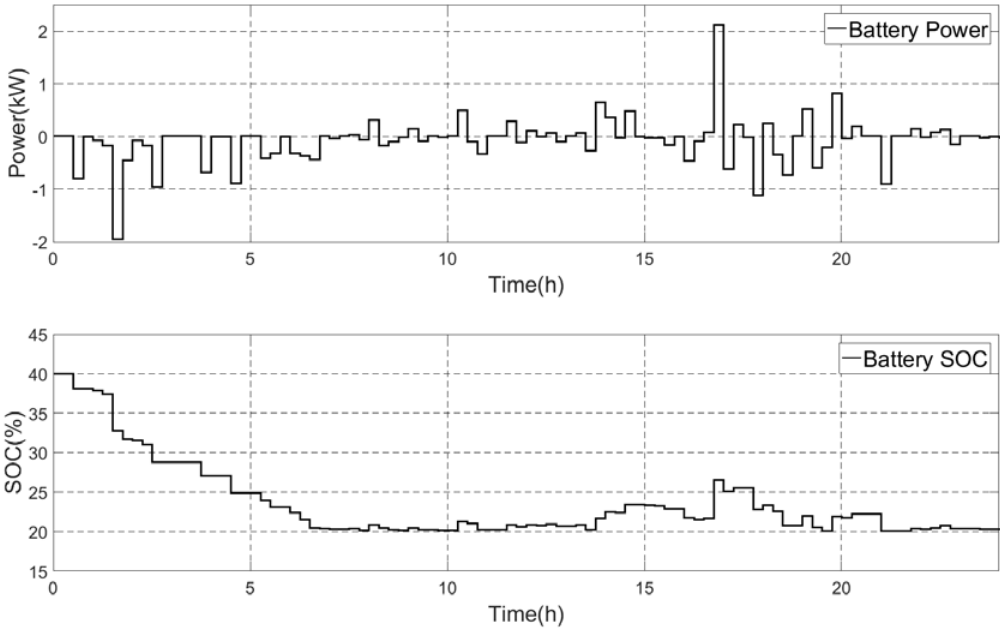
Figure 6. Scenario 1—Battery power (kW) and SOC (%).